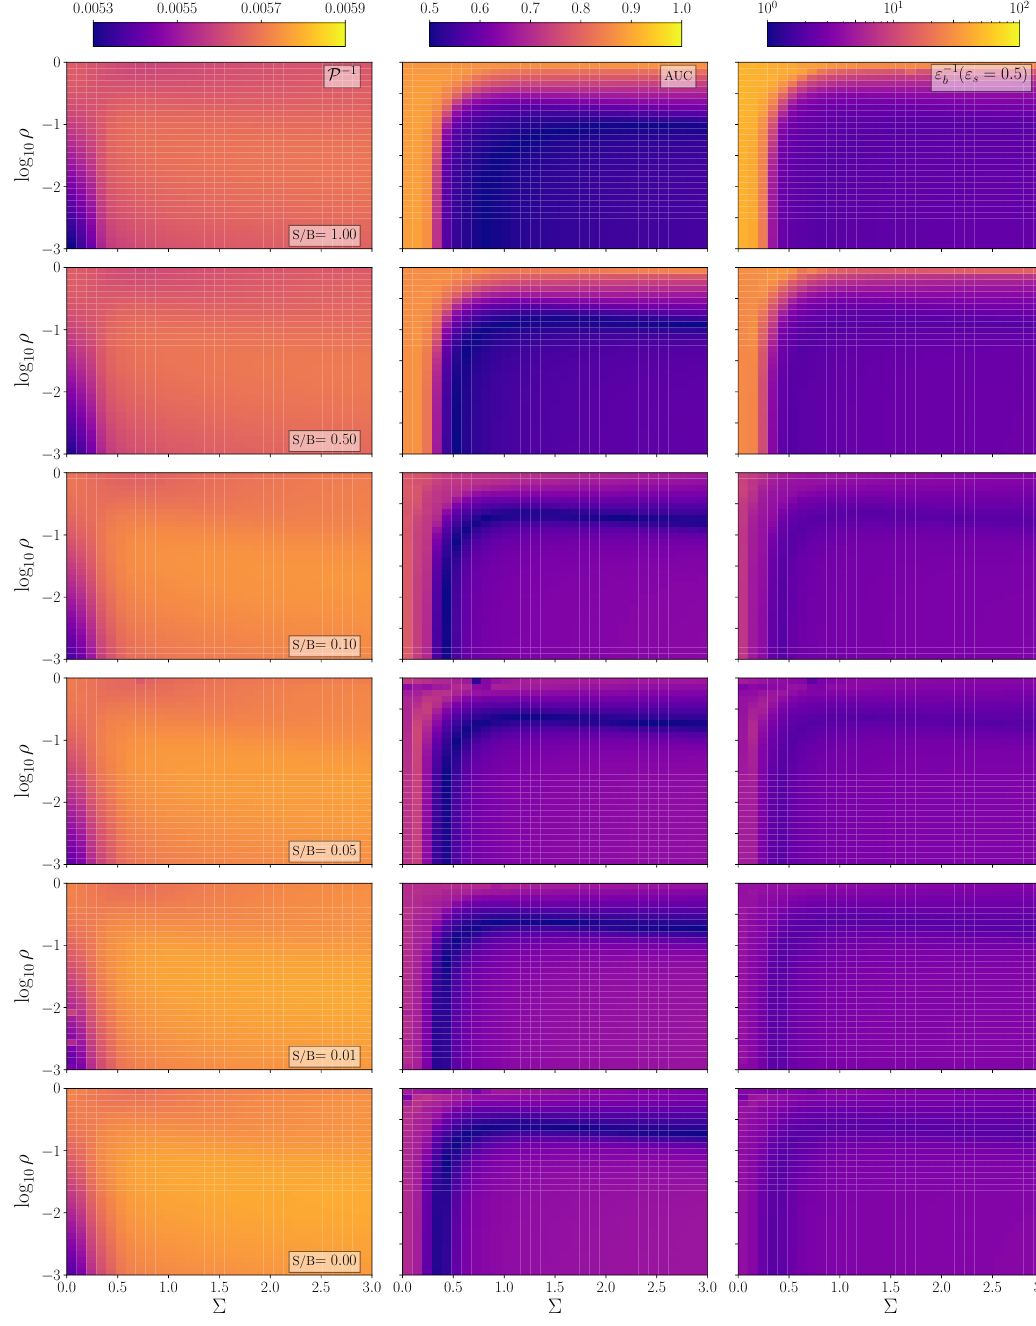
Figure 21 . Results of LDA models in the ( (cid:26); (cid:6)) parameter-space trained on samples of mixed t (cid:22) t and QCD events using Lund basis observables log k T and log R= (cid:1), with di(cid:11)erent S/B ratios (one per row). Each row contains plots of perplexity, AUC, and inverse mis-tag rate at (cid:12)xed e(cid:14)ciency. See text for